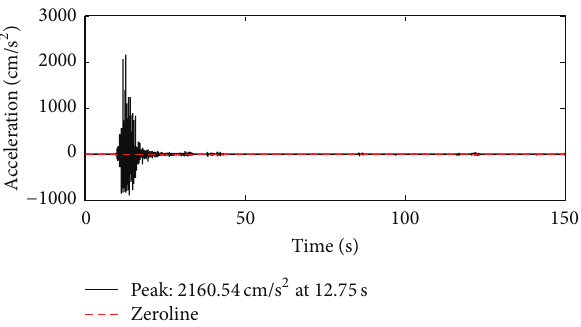
Figure 9: Acceleration time history (NZMQZ.raw, UP, ratl = 2.15, ratr =